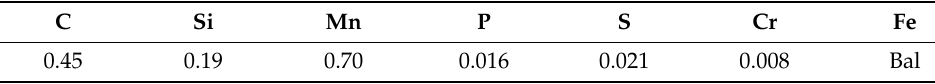
Table 2. Steel chemical composition (wt.%).